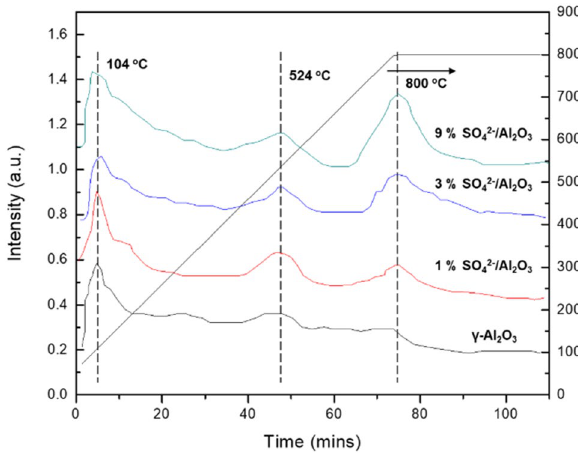
Figure 7. NH 3 -TPD curves of Al 2 O 3 catalysts.